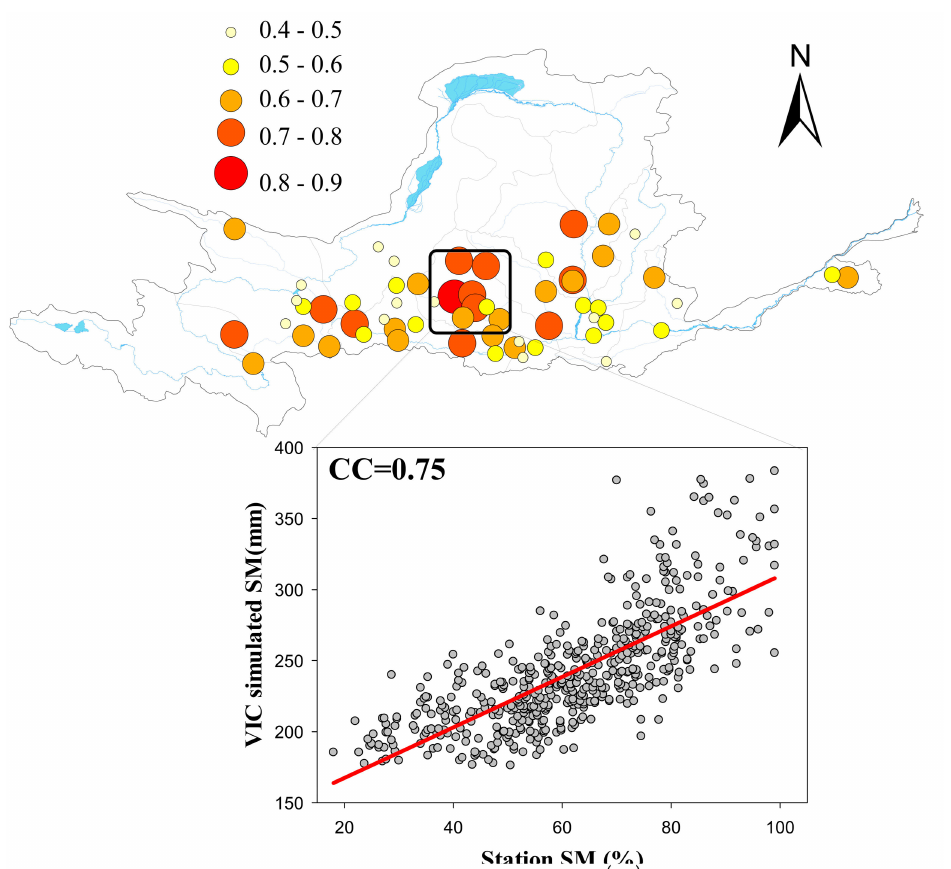
Figure 4. Spatial distribution of correlation coefficients between VIC simulated (average values of top two soil layers) and observed monthly soil moisture during